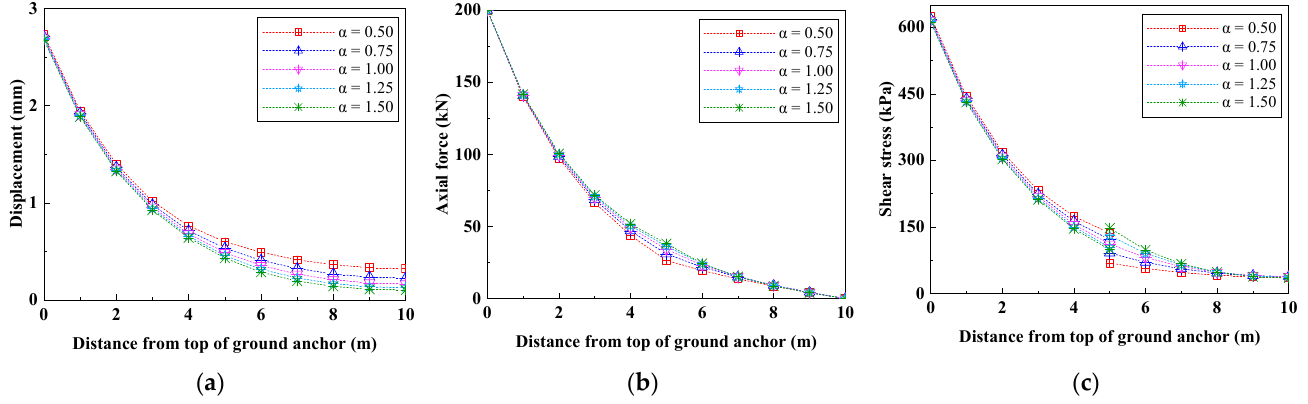
Figure 8. Effect of shear modulus change of Stratum-2 on mechanical behavior of ground anchor. (Case 1: condition 3) ( a ) displacement distribution curve; ( b ) axial force distribution curve; ( c ) shear stress distribution curve.